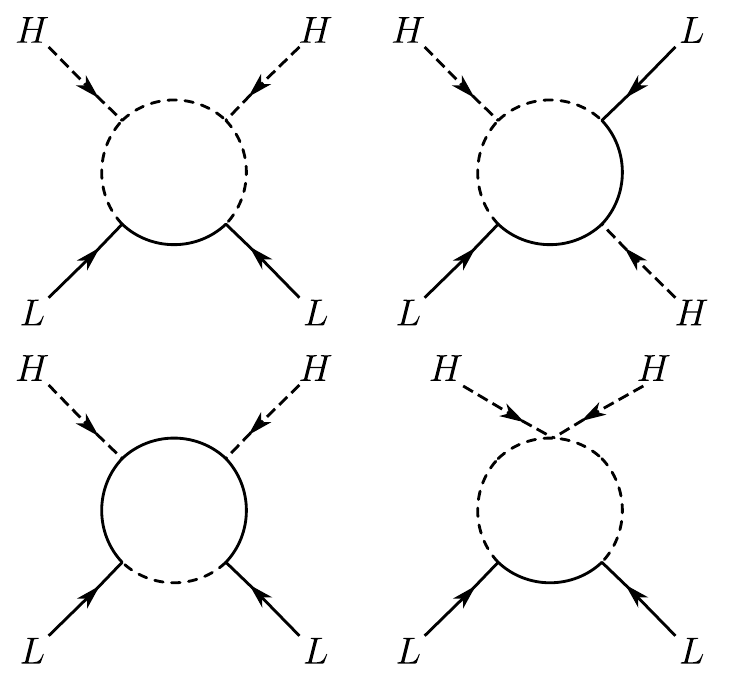
Figure 3 . The four genuine 1-loop d = 5 neutrino mass diagrams [13]. In the top panel we show the T-1-i diagram on the left and the T-1-ii diagram on the right. In the bottom panel, the T-1-iii diagram on the left and the T-3 diagram on the